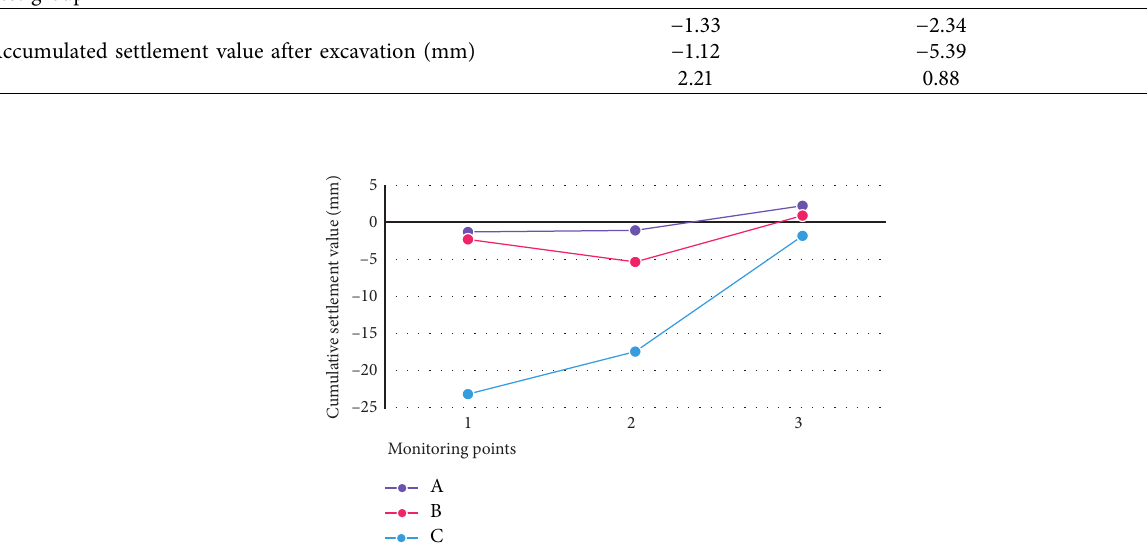
Figure 11: Variation curve of lateral displacement of monitored sections at Wannianquan Road